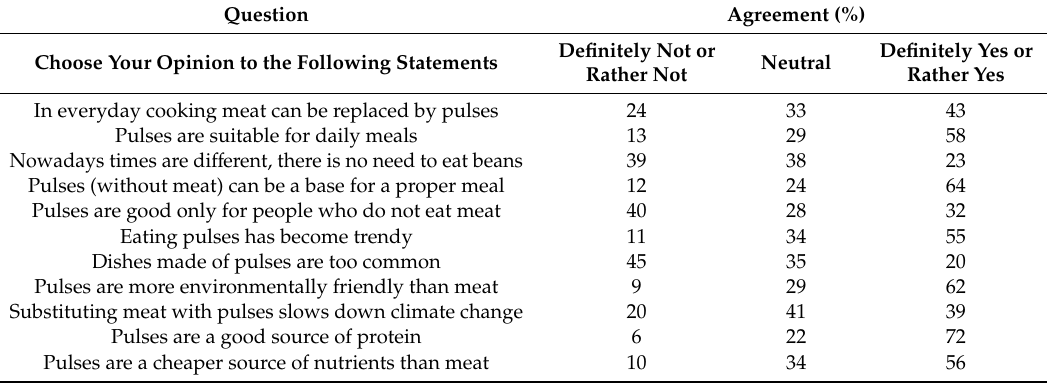
Table 3. Respondents’ compliance with opinions and attitudes concerning pulse